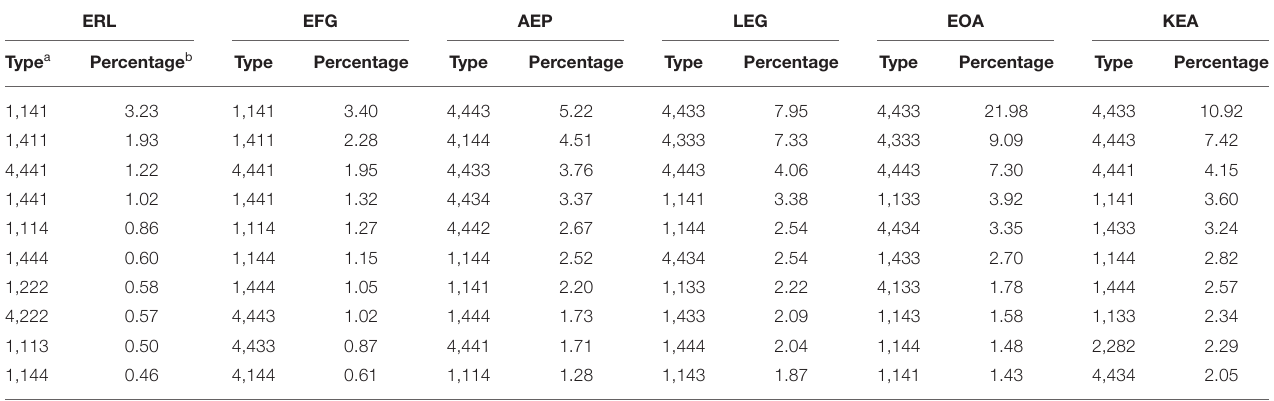
TABLE 1 | Land use change trajectories and their area proportion